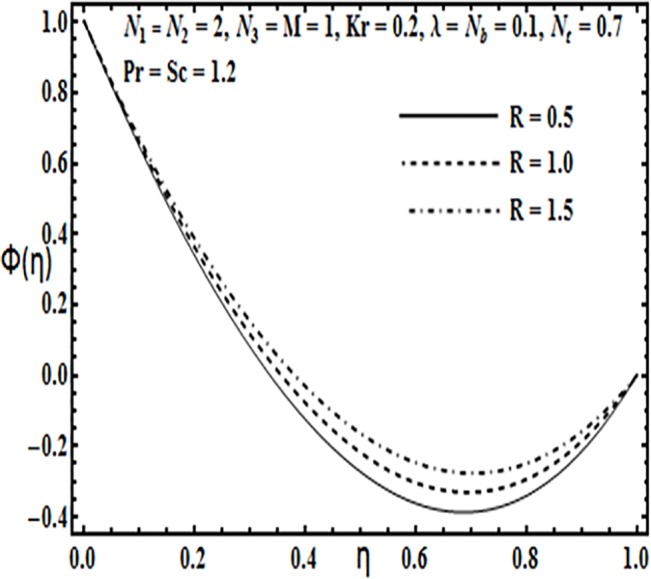
Effect of R on ϕ(η).